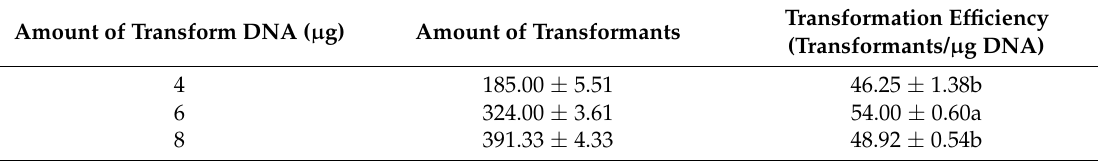
Table 4. Transformation efficiency of G. tritici .